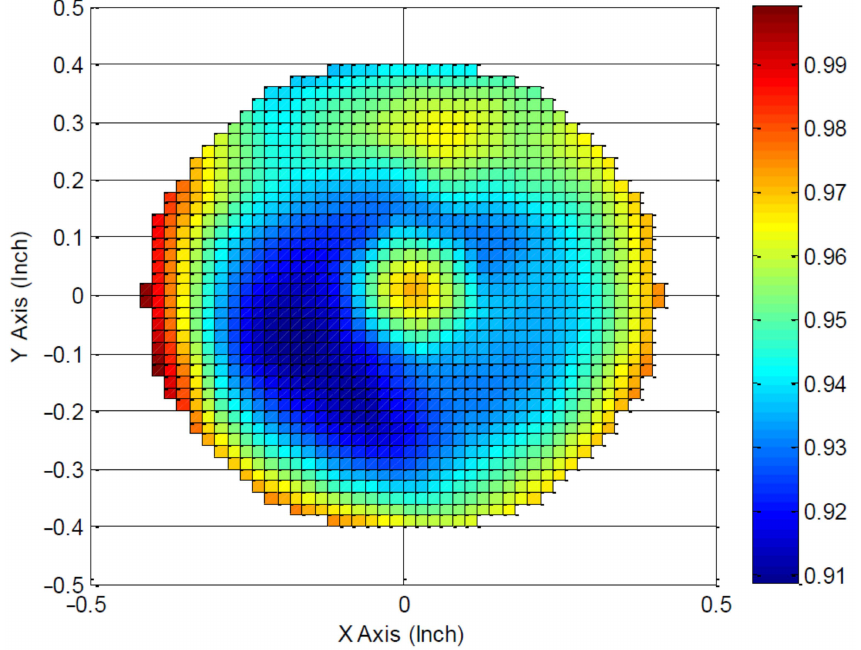
Figure 1. Irradiance uniformity map of solar spectrum simulator SF150-B with air mass filter